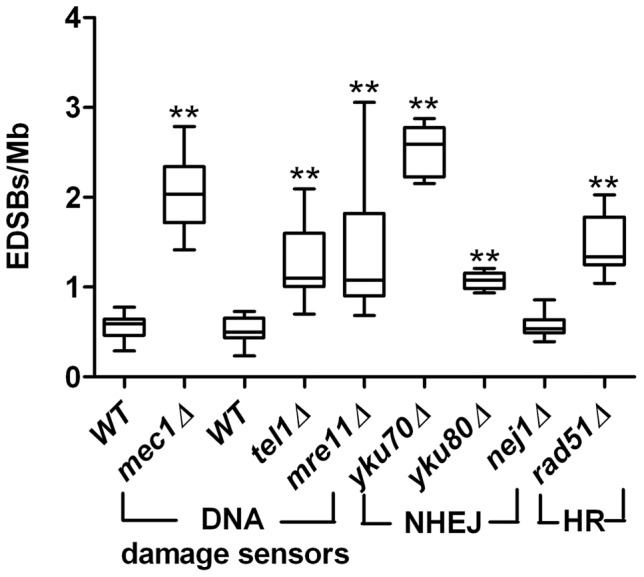
Levels of RIND-EDSBs in yeast strains with mutations in DSB repair pathways.The levels of RIND-EDSBs were significantly increased in G0 cells of mec1Δ, tel1Δ, mre11Δ, yku70Δ, yku80Δ, and rad51Δ but not in nej1Δ strains. The levels of EDSBs from 9 independent experiments are shown as box plots, with the boxes representing the interquartile ranges (25th to 75th percentile) and the median lines representing the 50th percentile. The whiskers represent the minimum and the maximum values. **P<0.001 (Mann-Whitney test).